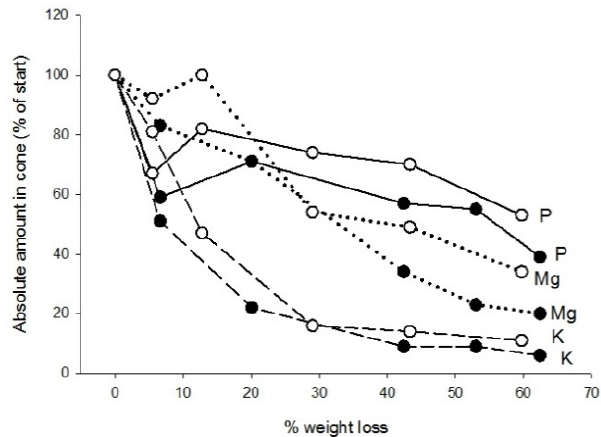
Figure 4. Changes in the absolute amount of phosphorus (solid lines), potassium (stippled lines) and magnesium (dotted lines) during decomposition of cones. Filled circles: moss habitat. Open circles: needle mat habitat. All lines start at 100% for newly shed cones. From [16].